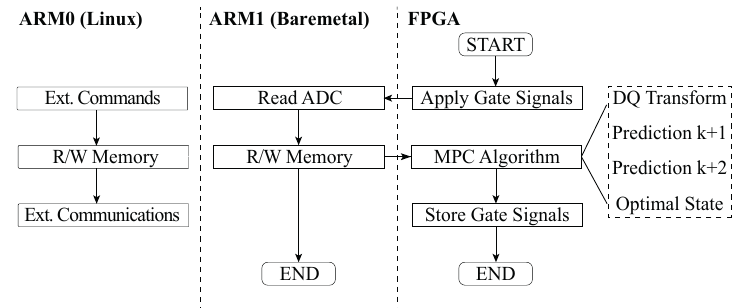
Figure 2. Flowchart of the general